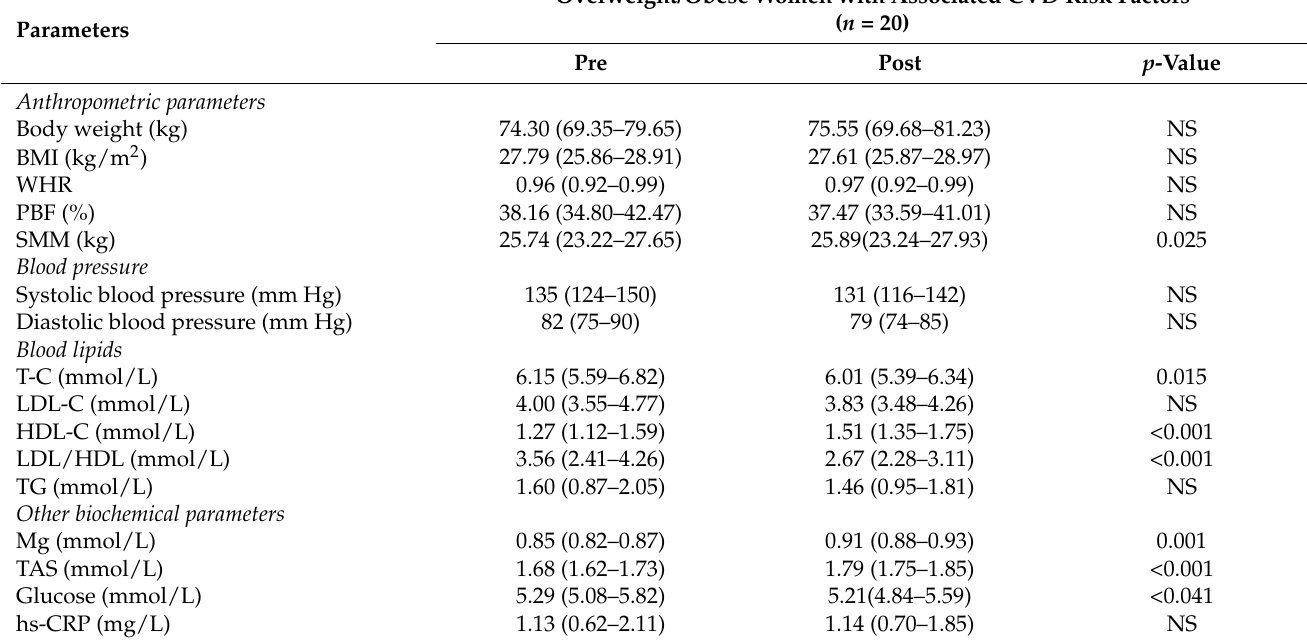
Table 3. Changes in anthropometric parameters, blood pressure, and plasma parameters of over- weight/obese women with associated CVD risk factors after (post) the apple/berry juice